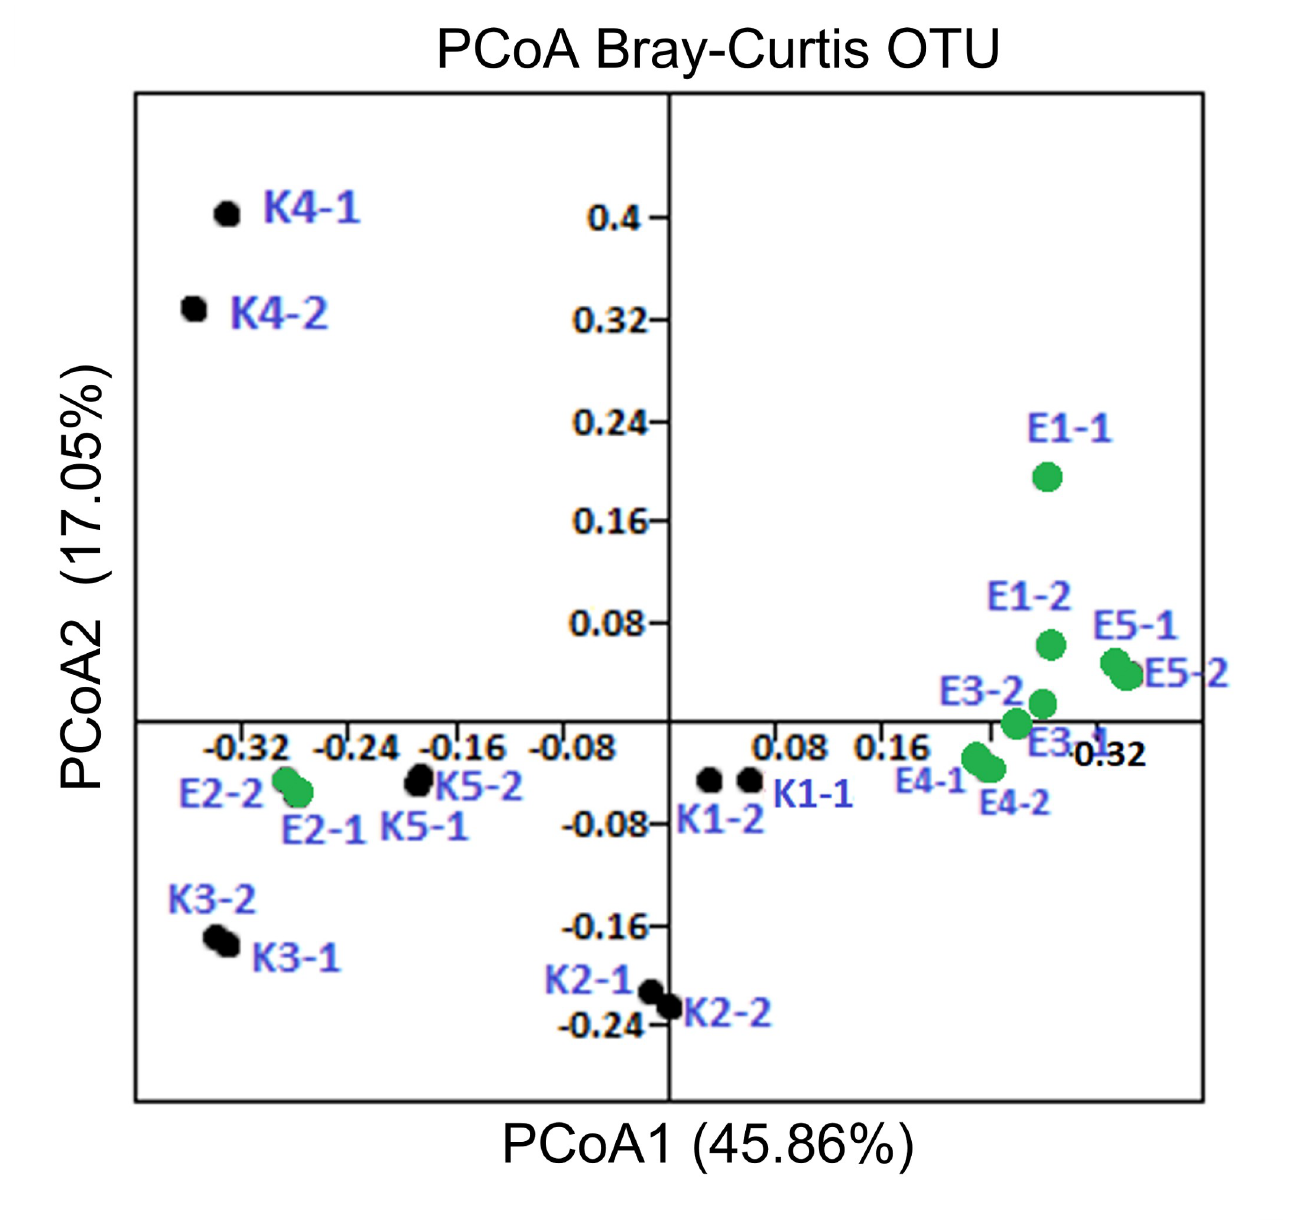
Fig 5. Visualisation of differences between carrot rhizosphere bacterial communities in soils from conventional (K1-1 - K5-2) and organic (E1-1 - E5-2) farms. Clustering based on Bray–Curtis dissimilarity of microbial community profiles in a principal coordinate plot.